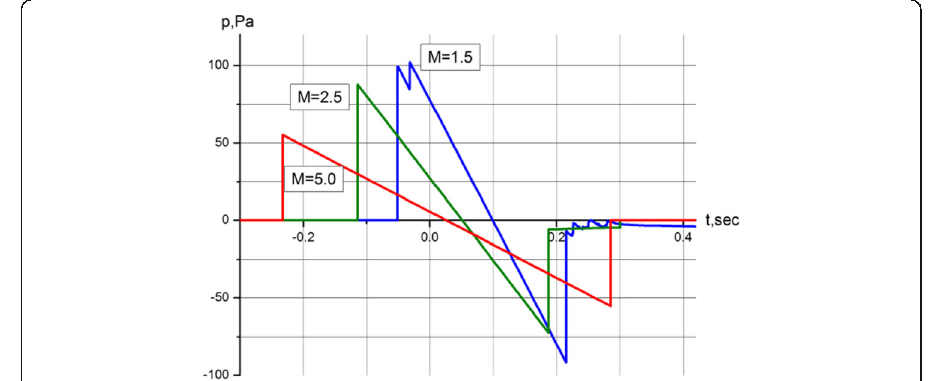
Fig. 11 Sonic boom intensity at different flight Mach